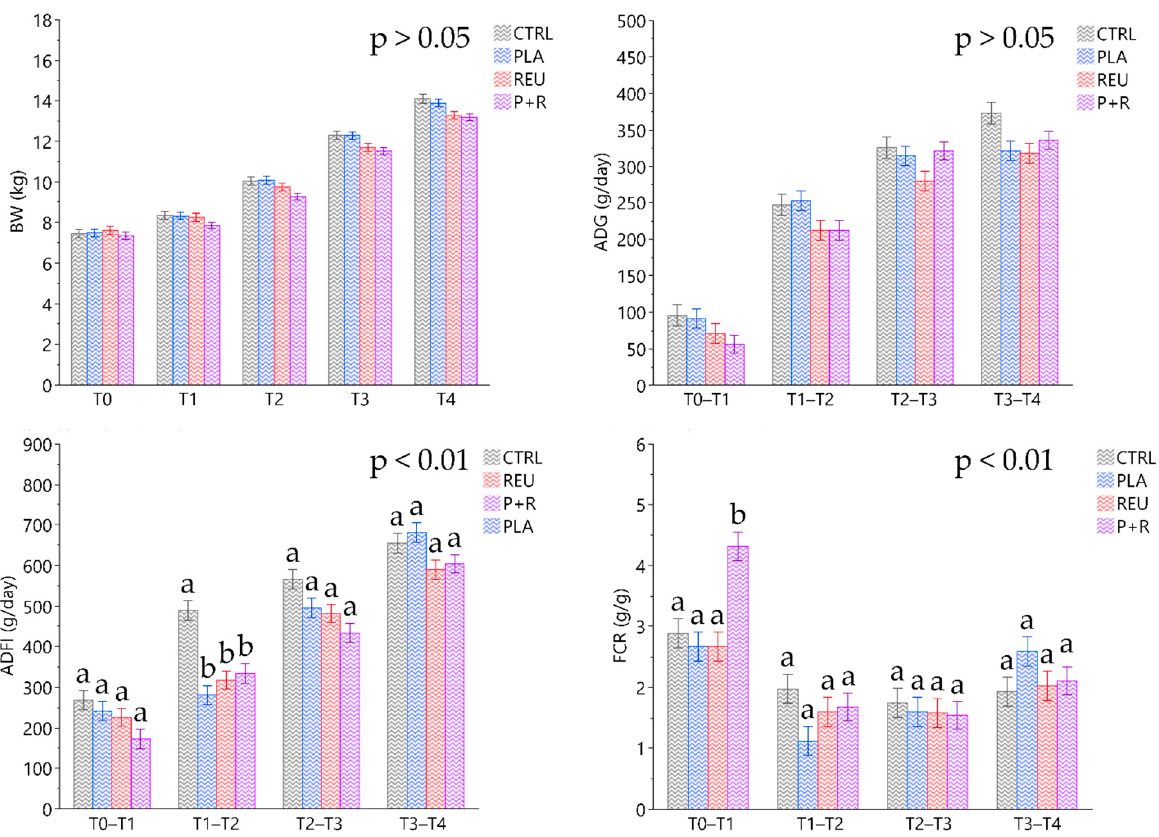
Figure 3. Zootechnical performance of control (CTRL) and treatment groups (PLA, REU and P+R) measured over 28 days of experimental trial. Data are expressed as least square means (LSMEANS) and standard errors of the means (SE); a,b Means with different superscripts are significantly different among treatments ( p < 0.01); Presented p -values indicate statistically significances of pairwise comparisons; BW: body weight; ADG: average daily gain; ADFI: average daily feed intake; FRC: feed conversion ratio; CTRL: control group; PLA: treatment group supplemented with 2 × 10 8 CFU/g of L. plantarum ; REU: treatment group supplemented with 2 × 10 8 CFU/g of L. reuteri ; P+R: treatment group supplemented with 2 × 10 8 CFU/g of L. plantarum and L. reuteri (1:1 w / w ).